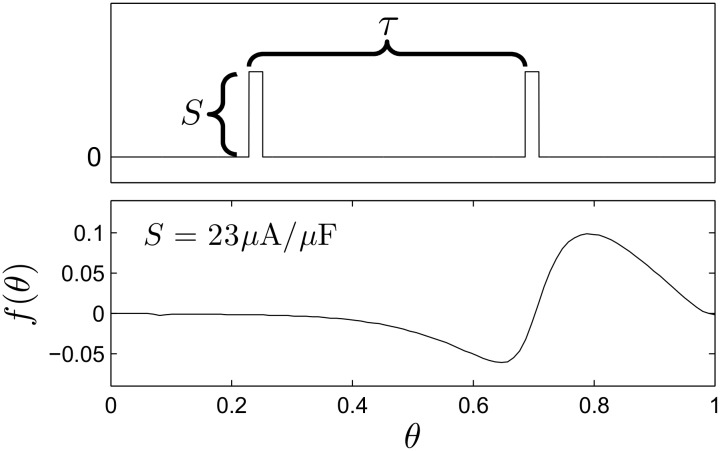
Monophasic DBS pulses.The top panel shows a pulsatile monophasic stimulus applied to the Hodgkin-Huxley neural network with frequency 1/τ and strength S. The bottom panel shows the relationship between pulse onset and the resulting change in phase.